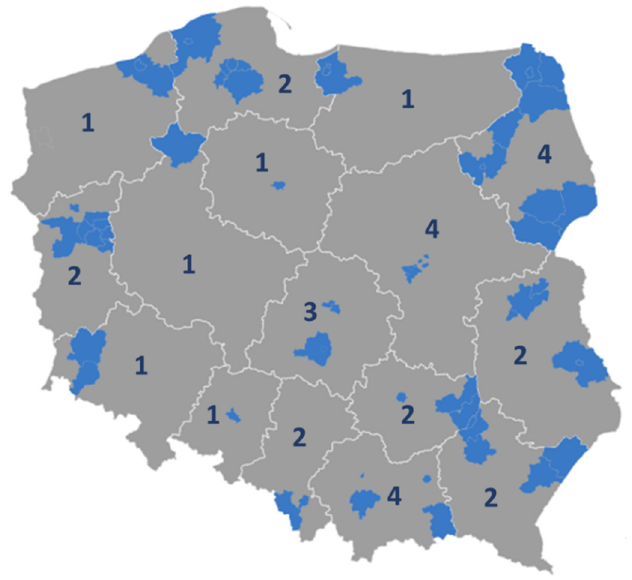
Figure 2. Number and location of mental health centres at the end of December 2021. Source: authors based on [30]. Notes: grey areas = regions; blue areas = catchment areas of mental health centres (this could be an area of one or more counties, or of a municipality or a smaller city, depending on the population density). The numbers represent the number of mental health centres in each region.